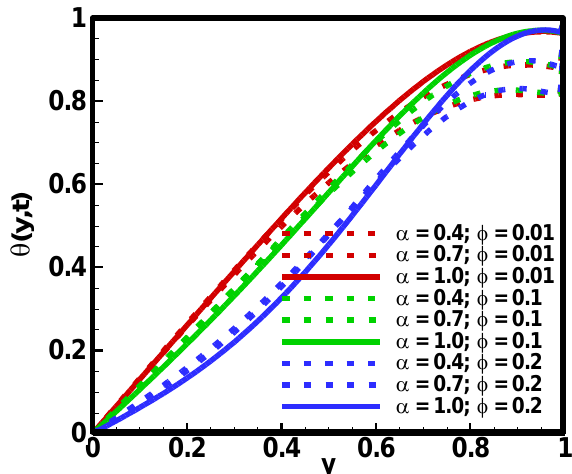
= 0.1, Pr = 21, and φ = 2